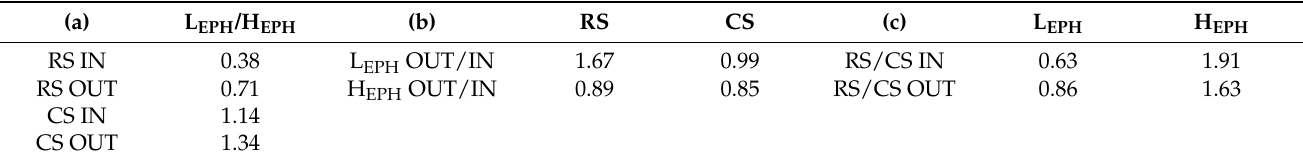
Table 2. EPH fractions UCM area ratios for RS and CS before (IN) and after (OUT)